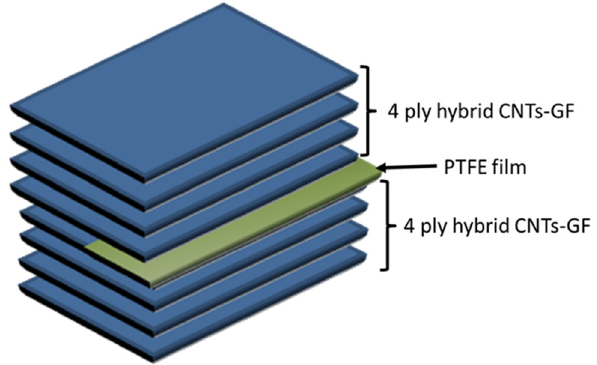
Figure 3: Illustration of sample preparation of hybrid CNTs -